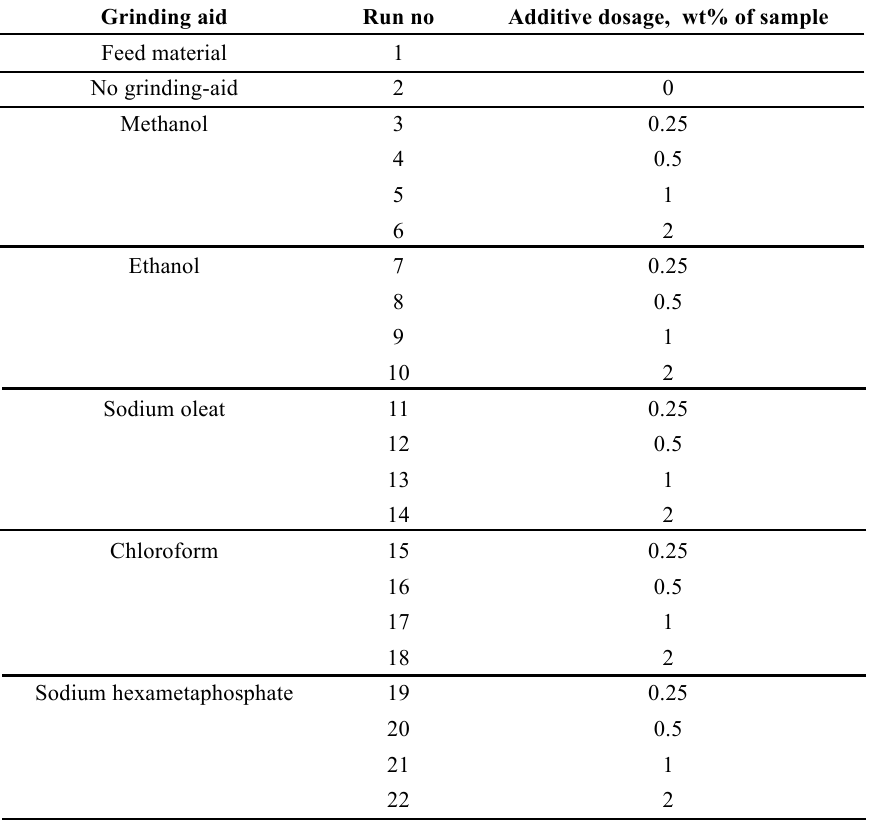
Table 4. Summary of experimental conditions